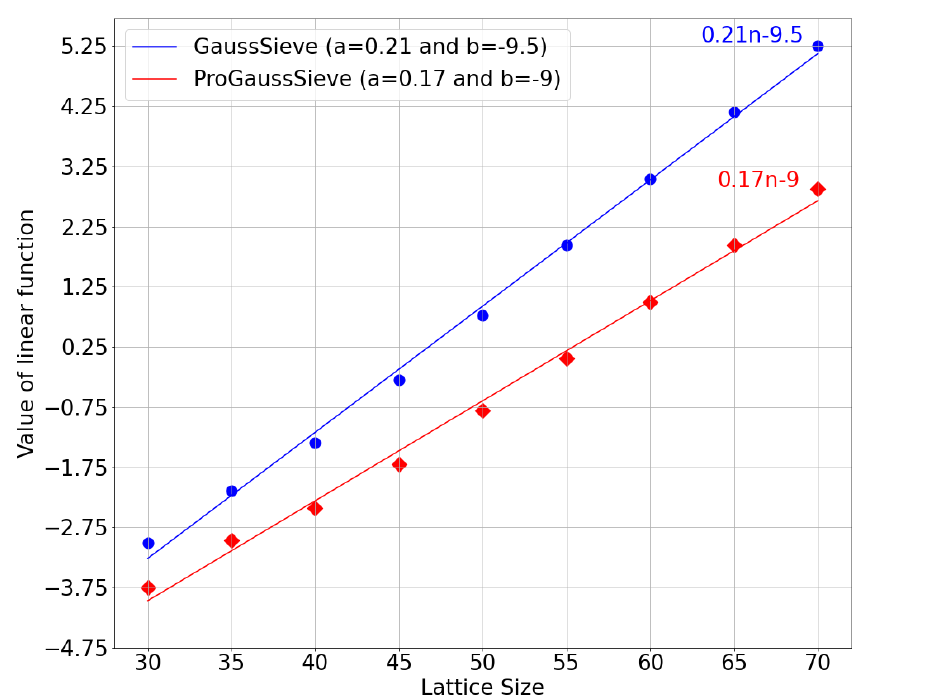
Figure 2. The exponential values of the run time